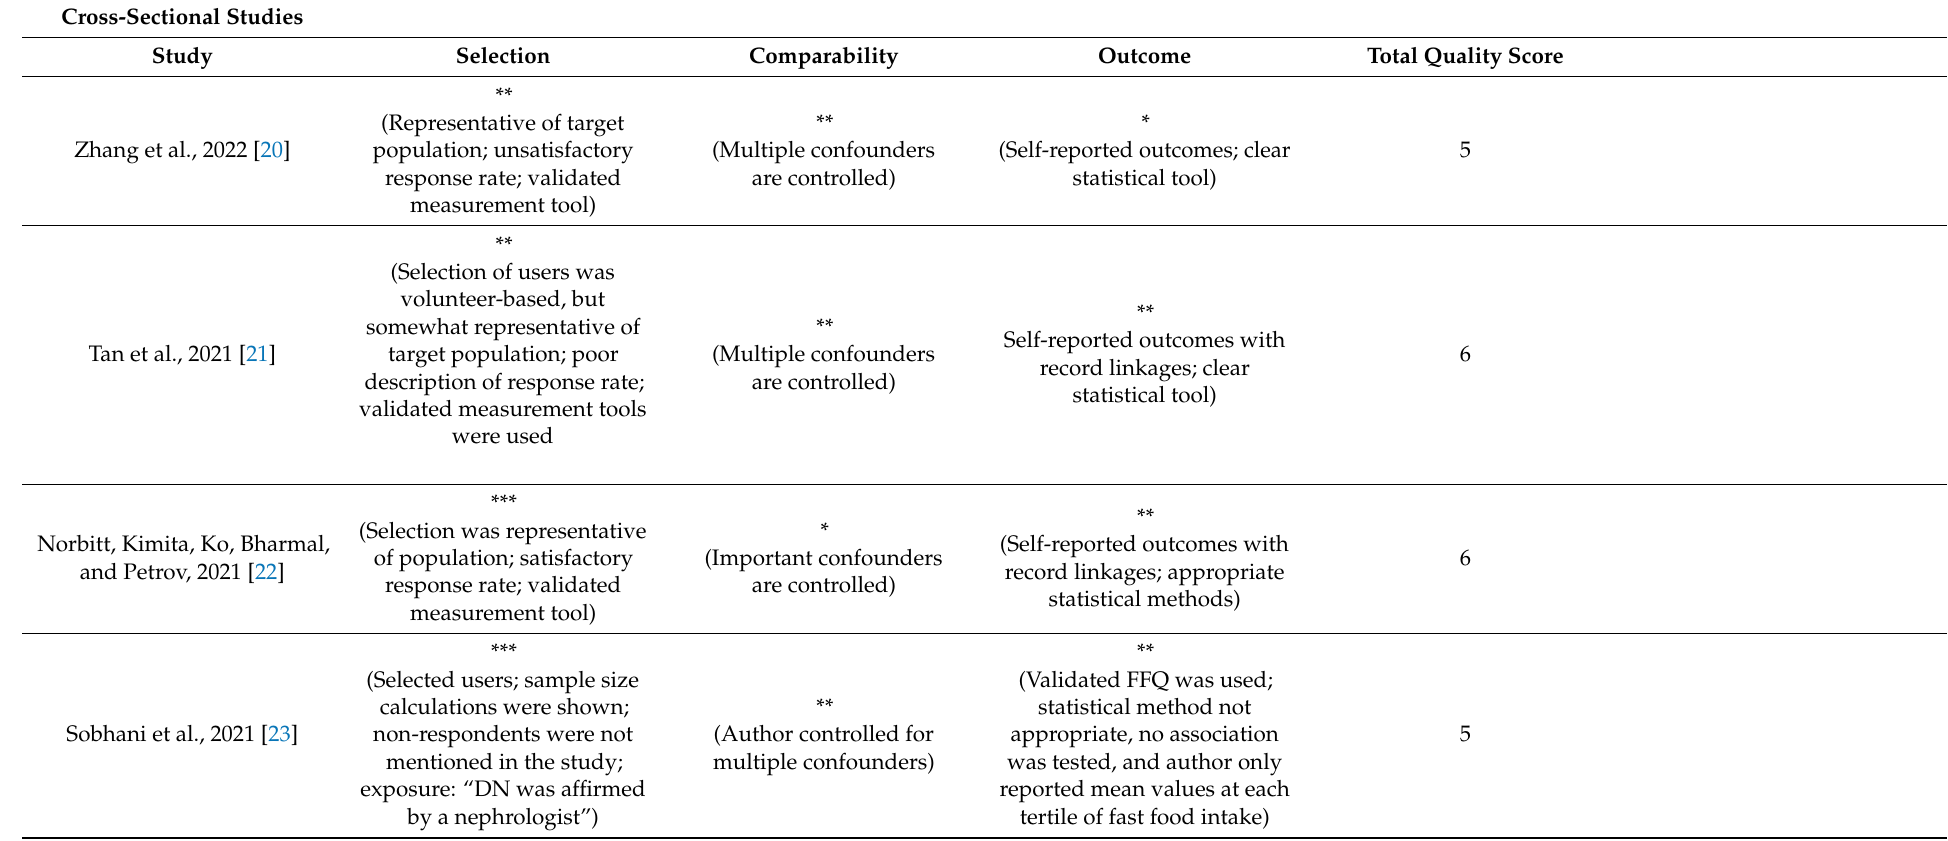
Table 3. Summary of the quality assessment of studies using Newcastle–Ottawa